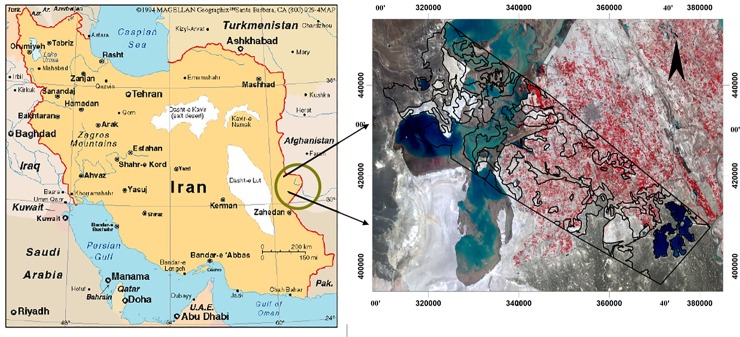
Study area[Image source from public domain: USGS EarthExplorer (https://earthexplorer.usgs.gov/)].